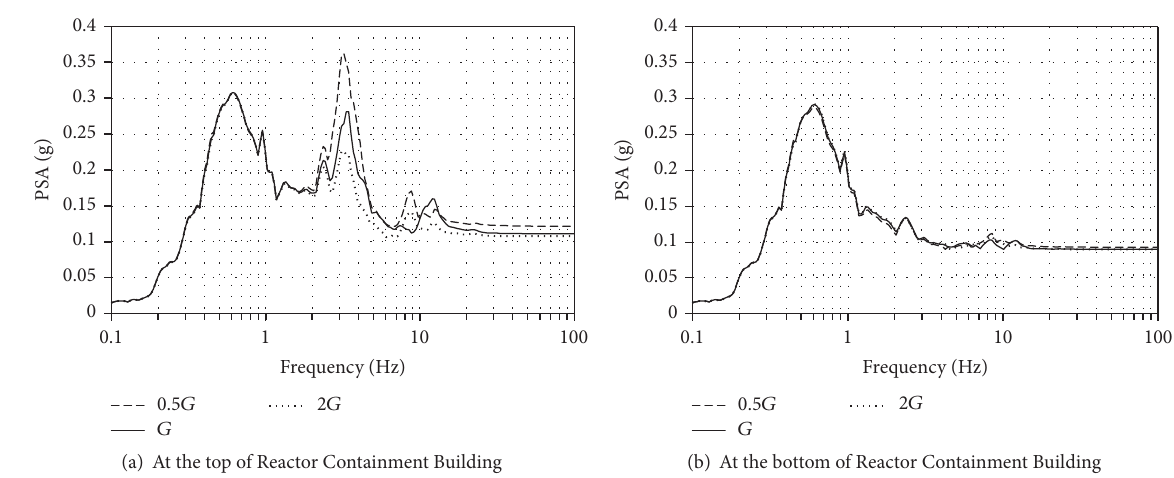
Figure 13: Comparison of response spectra acceleration under horizontal excitation for different soil shear